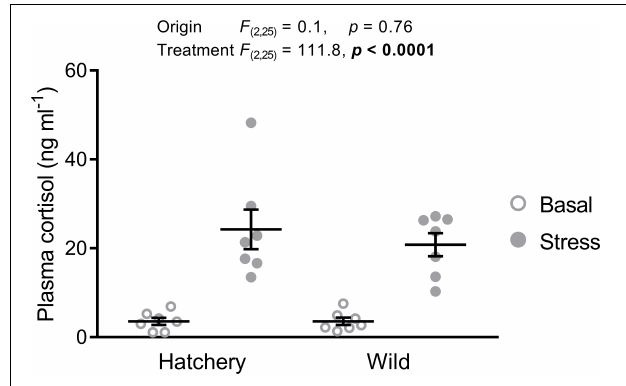
FIGURE 2 | Acute stress elevates plasma cortisol levels. Effect of origin (hatchery vs. wild) and treatment (basal vs. stress) on mean ± SEM plasma cortisol levels of Atlantic salmon parr. Two-way analysis of variance (ANOVA) statistics are displayed in the figure, n = 7 per